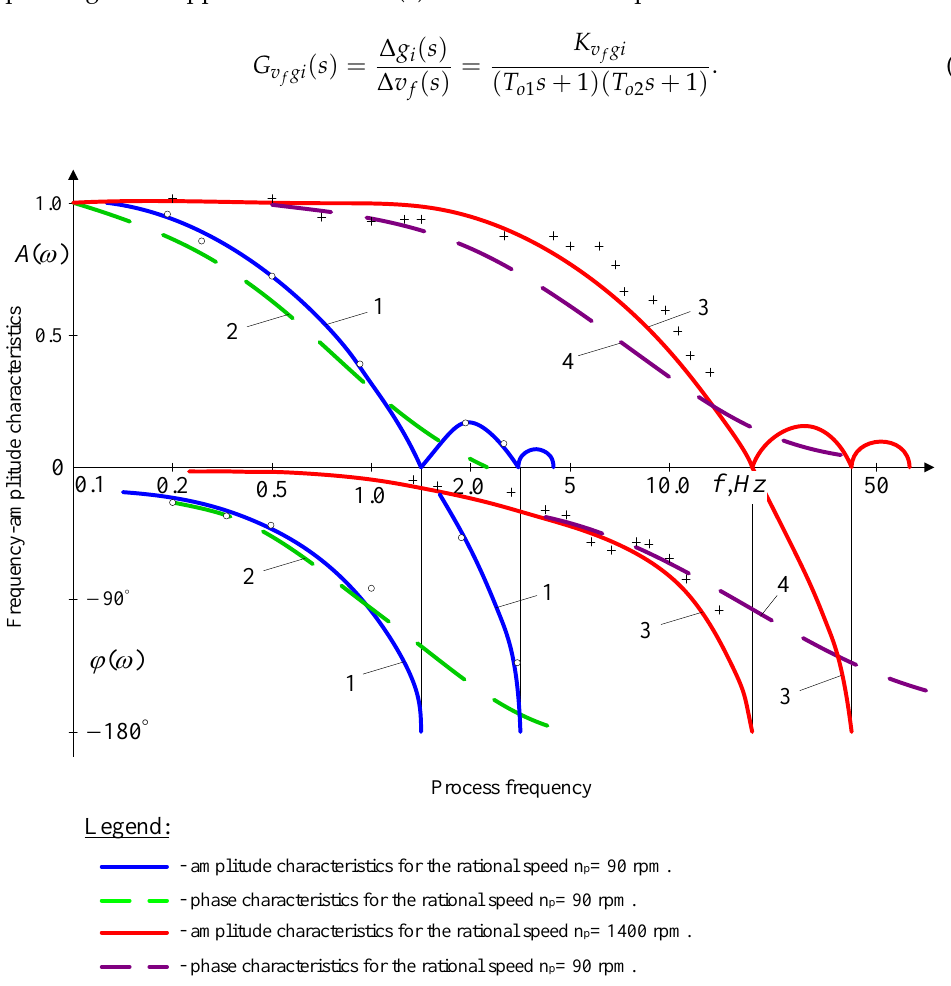
Figure 11. Frequency (amplitude and phase) characteristics of the control object under longitudinal feed control.